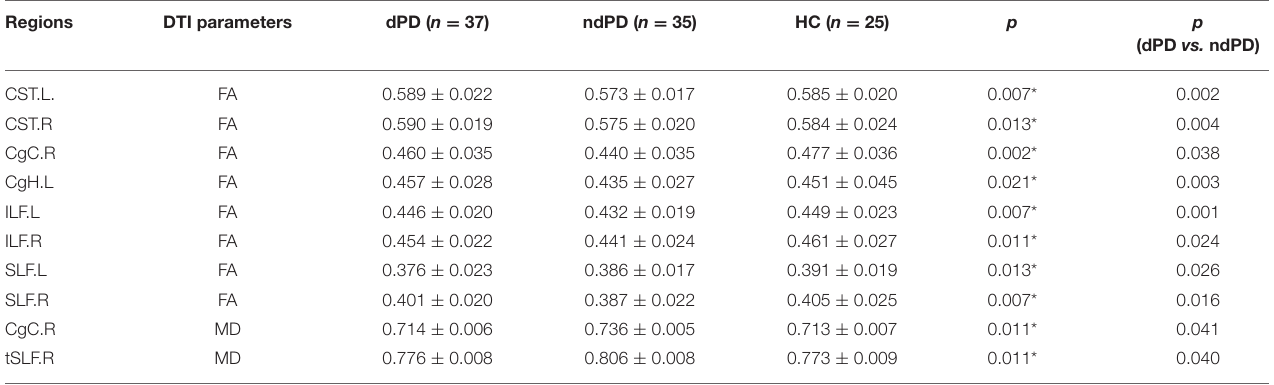
TABLE 2 | Brian WM regions with significant difference among dPD, ndPD, and HC. Regions